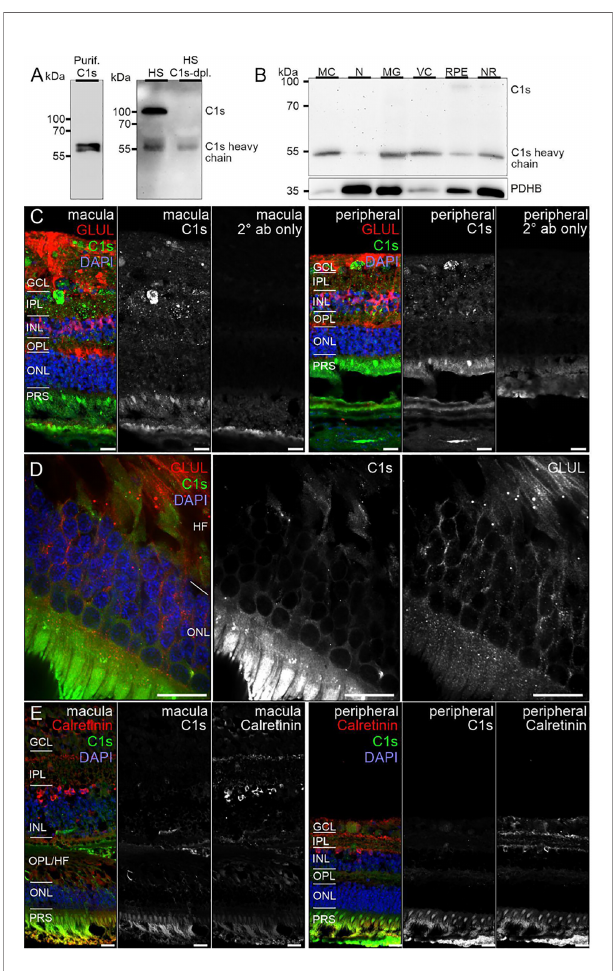
FIGURE 4 | C1s protein expression in the human retina. (A) Full C1s (~75 kDa) and the C1s heavy chain (~47 kDa) were reliably detected by Western blot using puri fi ed C1s protein and human serum (HS). C1s-depleted HS still contained remaining C1s heavy chain, while full length C1s was absent. (B) Western blot analysis of C1s on puri fi ed retinal cell types from peripheral human retina and RPE/choroid. The total protein extracted per cell population was loaded. PDHB (pyruvate dehydrogenase beta subunit) served as housekeeper that has been shown to be expressed at equal levels in all investigated cell types. In contrast to HS, primarily the heavy chain of C1s was detected in retinal samples. C1s levels were highest in Müller cells (MC) and vascular cells (VC). MG, microglia; NR, whole neuroretina. RPE, retinal pigment epithelium including choroid. (C) Representative micrographs of C1s-stainings from macular ( left ) and peripheral ( right ) retinae. Photoreceptors and cells of the ganglion cell layer (GCL) as well as punctate structures in the inner plexiform layer (IPL) displayed highest labeling intensities. Sections were co-stained for the Müller cell marker glutamine synthetase (GLUL). (D) Higher magni fi cation of the outer nuclear layer (ONL) and Henle fi ber layer (HL) in the macular retina showed a partial overlap of C1s and GLUL. (E) Co-staining of C1s with calretinin, a marker of inner retinal neurons such as ganglion and amacrine cells, yielded no considerable overlap. (C-E) INL, inner nuclear layer; OPL, outer plexiform layer; PRS, photoreceptor inner and outer segments. Scale bars, 20 µm.